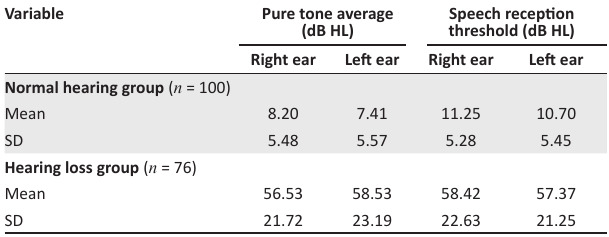
TABLE 1: Pure tone average and isiZulu speech reception threshold measurements for right and left ears for participants with normal hearing and with hearing